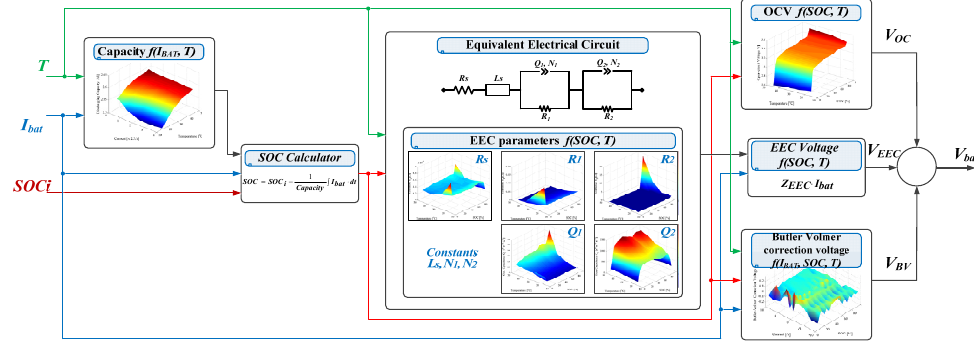
Figure 18. Block diagram implementation of the performance model for the LFP/C battery.